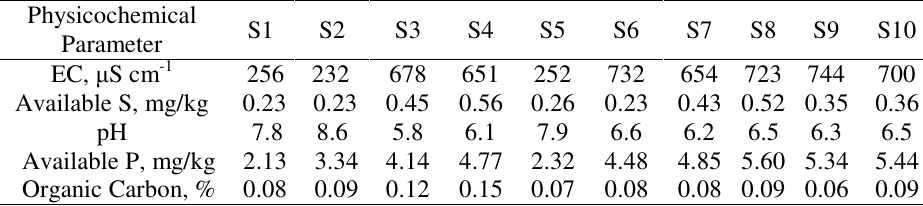
Table 2. Physicochemical characterization of